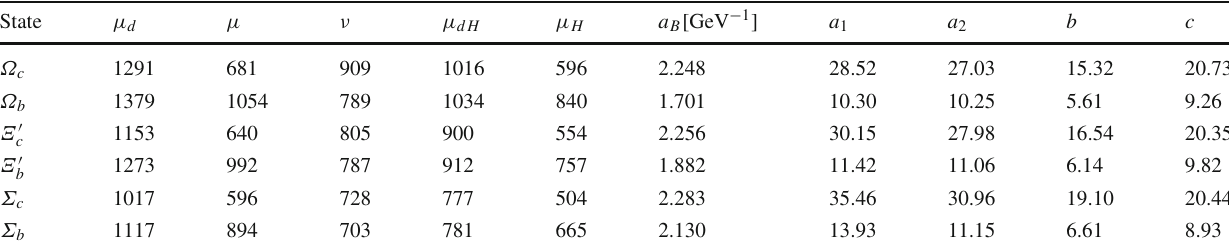
Table 10 Spin coupling parameters a 1 , a 2 , b and c calculated by Eq. (40), the AF fields ( μ,ν ) solved from Eq. (C4) (Appendix C) and other related parameters for the P-wave states. All in MeV except for a